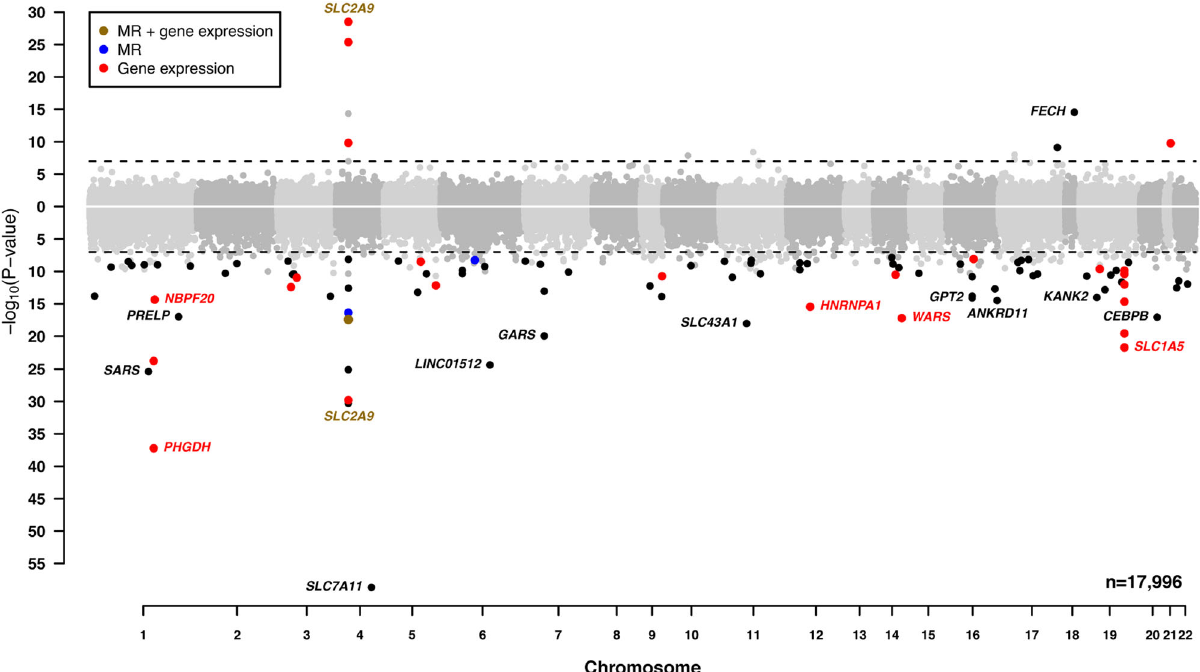
Fig. 2 CpGs in the EWAS of serum urate from the combined meta-analysis of discovery and replication results ( n = 17,996). The CpGs are ordered by their chromosomal position on the x -axis with their – log 10 ( p value) of the association on the y -axis. CpGs with positive and negative effect estimates are plotted in the upper and lower panels, respectively. The dotted horizontal lines represent the level of signi fi cance corrected for multiple testing (two-sided p < 1.1E – 7). Black: replicated CpGs; brown: gene with replicated CpGs associated with gene expression in monocytes and signi fi cant causal effects for serum urate; blue: replicated CpGs with signi fi cant causal effects on serum urate or gout; red: replicated CpGs associated with gene expression in monocytes or whole blood. Gene names are displayed if the gene had at least one CpG with p value < 1E – 14. MR Mendelian